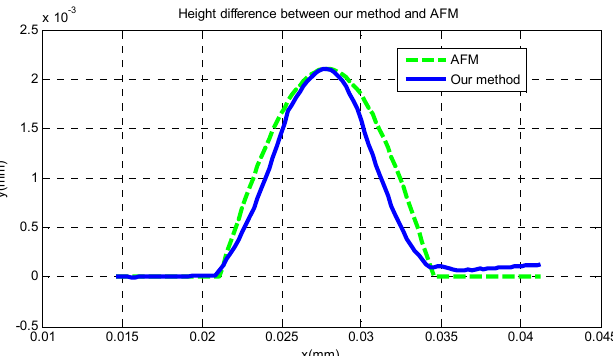
Figure 19. The profiles of the microlens with AFM and our method.